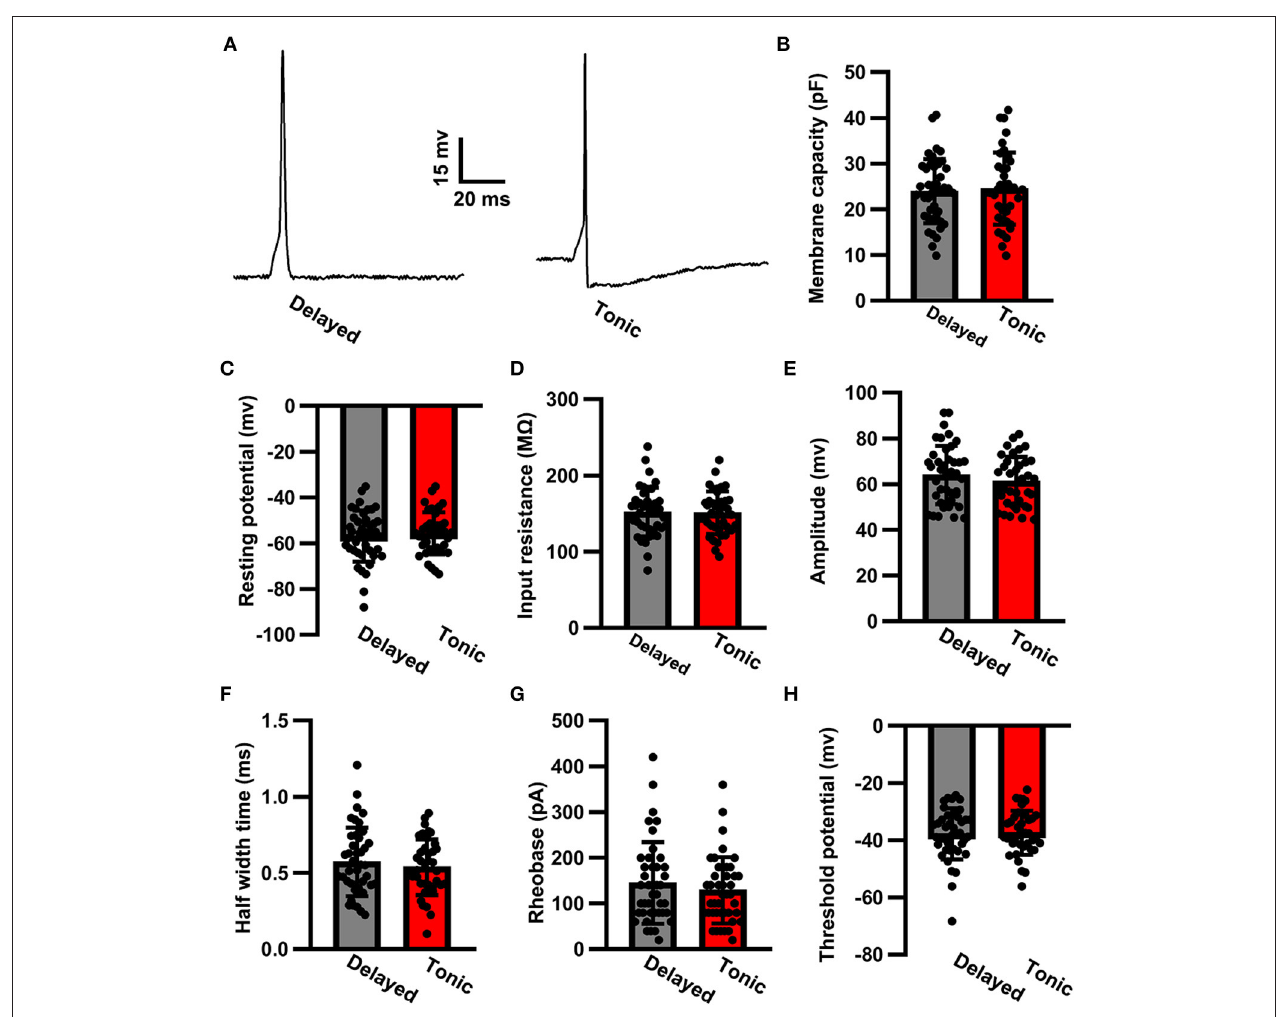
FIGURE 2 | The action potential properties of SG neurons. (A) Examples of evoked action potential. Comparison of membrane capacity (B) , resting potential (C) , input resistance (D) , amplitude (E) , half-width time (F) , rheobase (G) , and threshold potential (H) of action potentials between delayed-firing pattern and tonic-firing pattern neurons. Data were shown as mean ± SEM. The time scale bar is 20ms and the amplitude bar is 15mv.